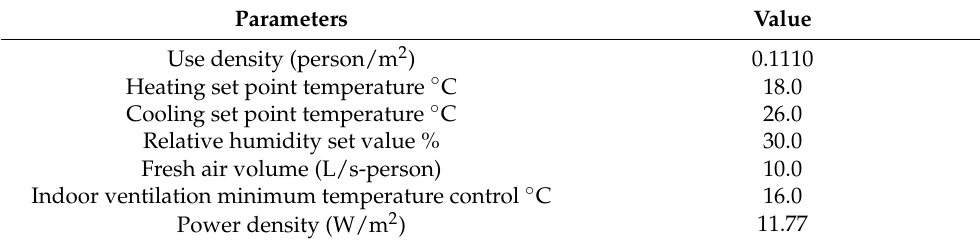
Table 1. Building energy simulation setting parameters.